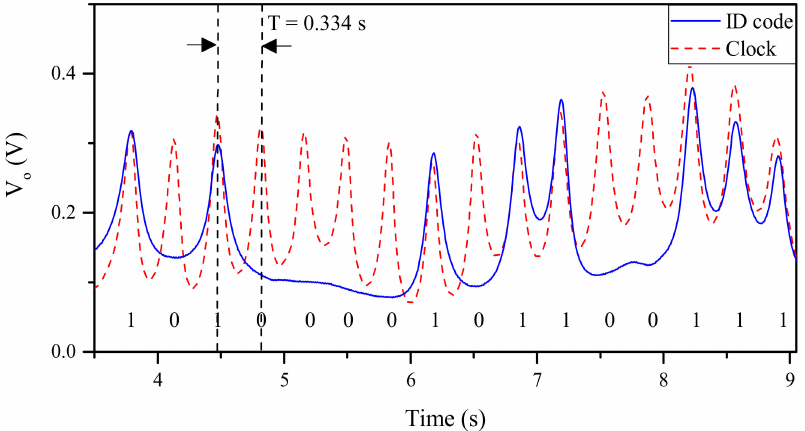
Figure 19. Measured envelope functions for the clock and ID code signals tuned to f 0 l = 3.155 GHz and f 0 u = 4.229 GHz